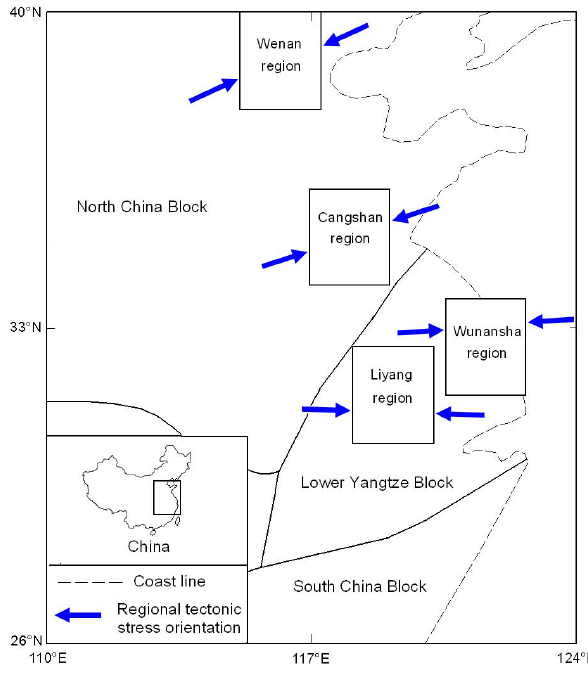
Fig. 1. Locations of the four study regions and the regional tectonic stress orientations. The Liyang and Wunansha regions are located in the lower Yangtze block of China, while the Cangshan and We- nan regions are located in the North China Block. The azimuths of tectonic stress orientation (the greatest compressive stress direc- tion) of the Liyang, Wunansha, Cangshan and Wenan regions are 92 ◦ , 87 ◦ , 72 ◦ and 66 ◦ , respectively, according to the study by Xie et al.